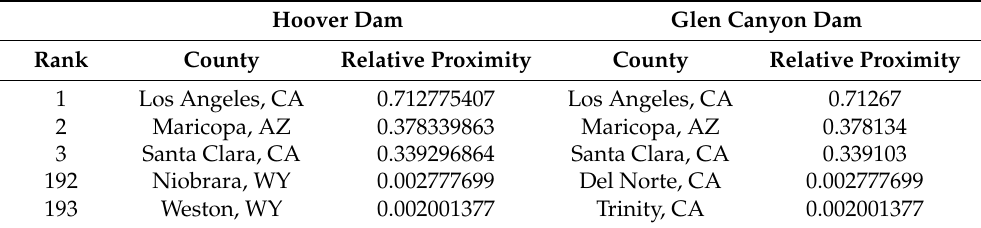
Figure 7. The weight distribution of four major attributes. ( a ) The HD. ( b ) The GCD. The relative proximity of the 193 counties to HD and GCD was calculated using the improved model derivation. The results are presented in Table 3. Table 3. Relative proximity of each county. Only the first three and the last two are excerpted here. Hoover Dam